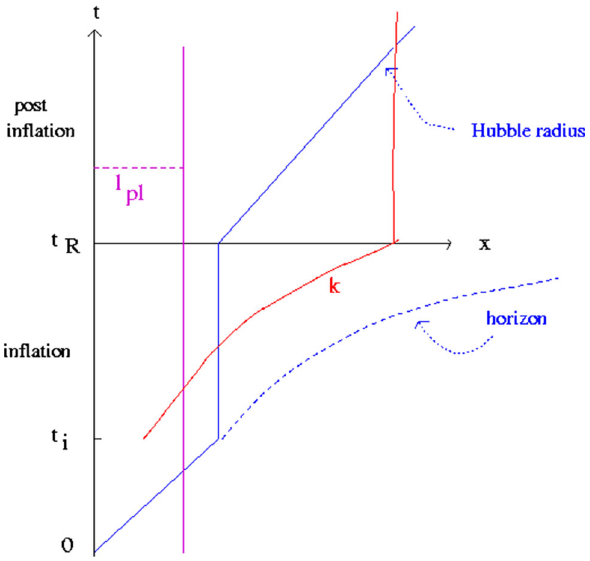
Fig. 2 A space-time sketch of inflationary cosmology. As in Fig. 1, the vertical axis is time, the horizontal axis denotes physical distance. In addition to the Hubble radius, the horizon and the physical wave- length corresponding to a fluctuation mode which expands as the size of space increases (the curve denoted by k ), we show the vertical curve coresponding to the Planck length. Unless the period of inflation is only very slightly larger than the minimal duration it has to have to solve the problems of Standard Cosmology, the physical wavelength correspond- ing to our current Hubble radius is smaller than the Planck length at the beginning of